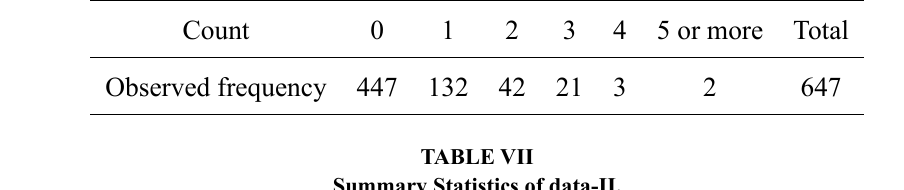
Summary Statistics of data-II.